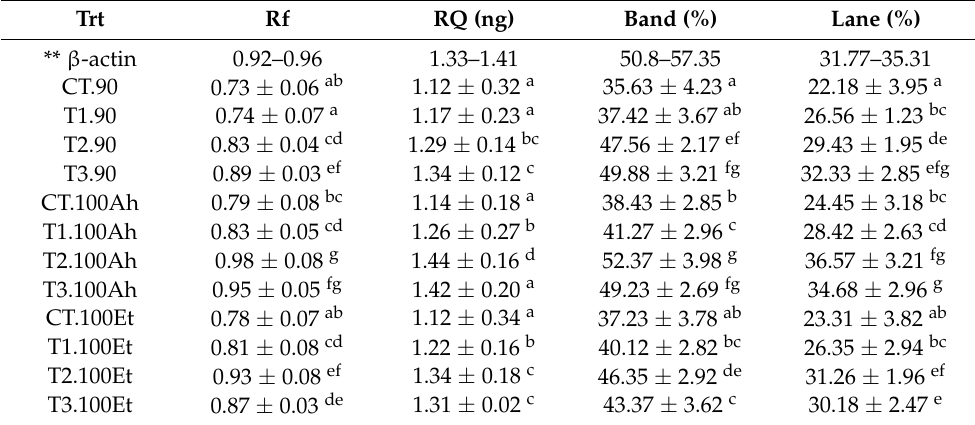
Table 4. Showing densitometry parameters of the STAT 1